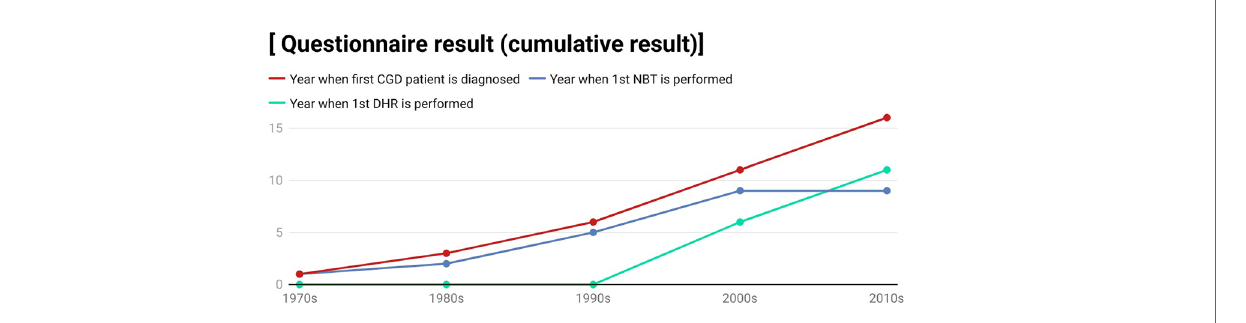
FIGURE 6 | A line graph showing the questionnaire result which we deliver to various immunology centres. This graph is created by using the app Datawrapper.